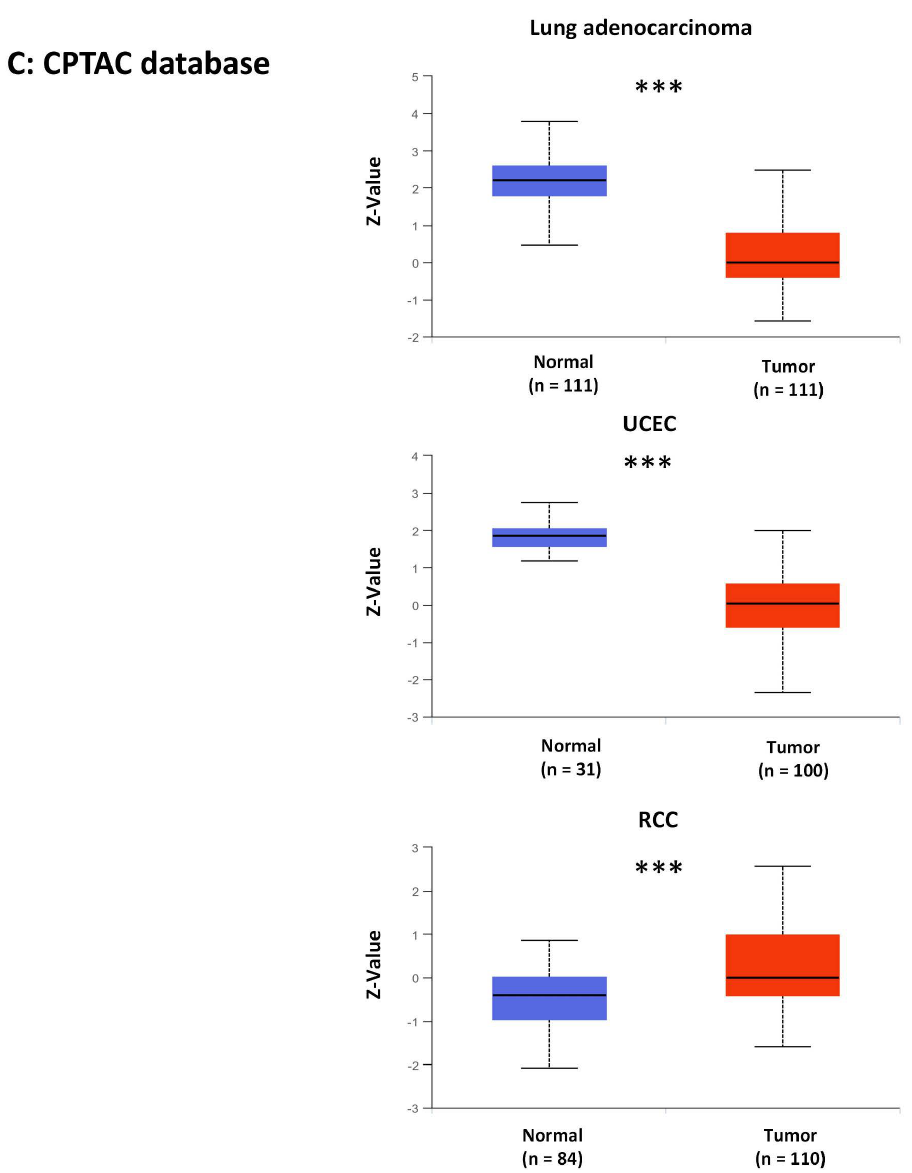
Figure 1. The ABCG2 expression data were obtained from various databases: ( A ) Data collected from TCGA database and analyzed by the TIMER2.0 database. Samples with gray backgrounds represent both tumor (red) and normal tissue (blue) samples and one metastasis (purple), which can be compared statistically. Samples with white backgrounds represent only tumor samples, which cannot be compared statistically because other types of tissue samples were not available (* p < 0.05; ** p < 0.01; *** p < 0.001). ( B ) We used normal tissue data from the Genotype-Tissue Expression (GTEx) database as controls for comparisons with the corresponding data from The Cancer Genome Atlas (TCGA) project. The results are presented as a box plot (* p < 0.05). Tumor samples in red and normal samples in black. ( C ) Expression levels of ABCG2 protein were also compared between tumor tissue (red) and normal tissue (blue) in LUAD (lung adenocarcinoma), UCEC (uterine corpus endometrial carcinoma), and RCC (clear cell renal cell carcinoma (RCC)) based on the CPTAC dataset (*** p <